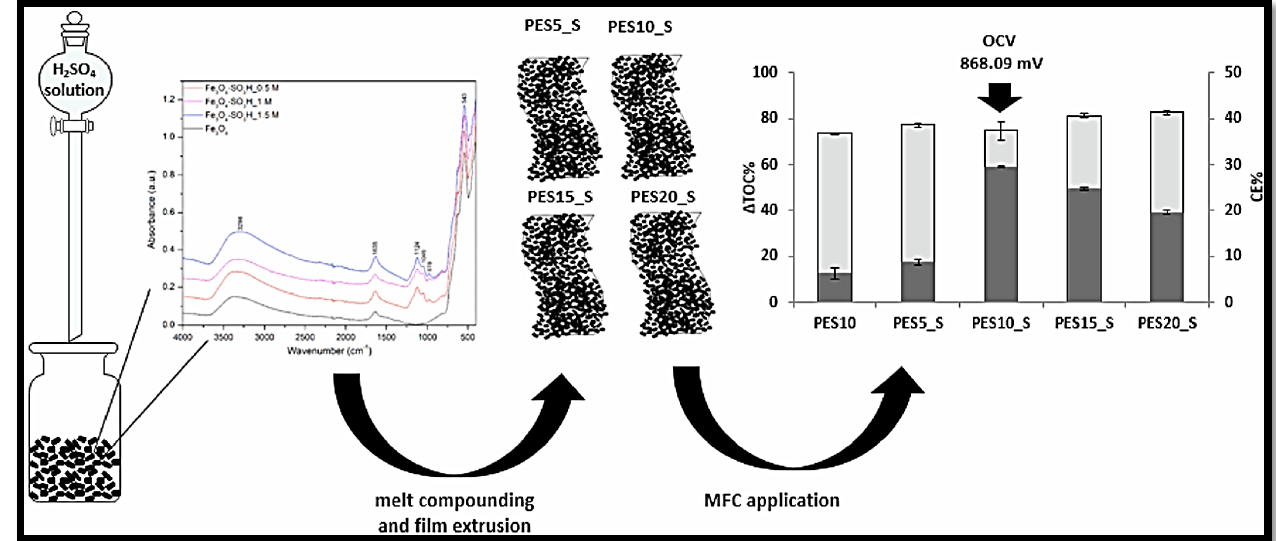
Figure 7. The overall process (FT-IR spectra of Fe 3 O 4 and sFe 3 O 4 ) and performances (coulombic efficiency (grey) and total organic carbon removal) of sulfonated Fe 3 O 4 /PES nanocomposite membranes. Reproduced from [162], with permission from Elsevier, 2020. Table 4. Physicochemical properties and performance evaluation results of different kinds of sul- fonated additives containing polymer membrane for MFC applications.